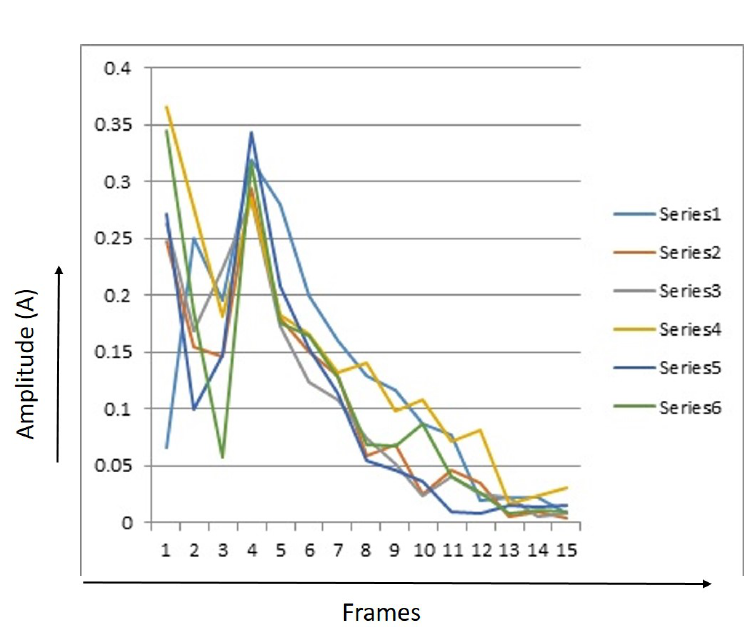
Figure 7. 15 Points Root Mean Square (RMS) values of 6 event signals of